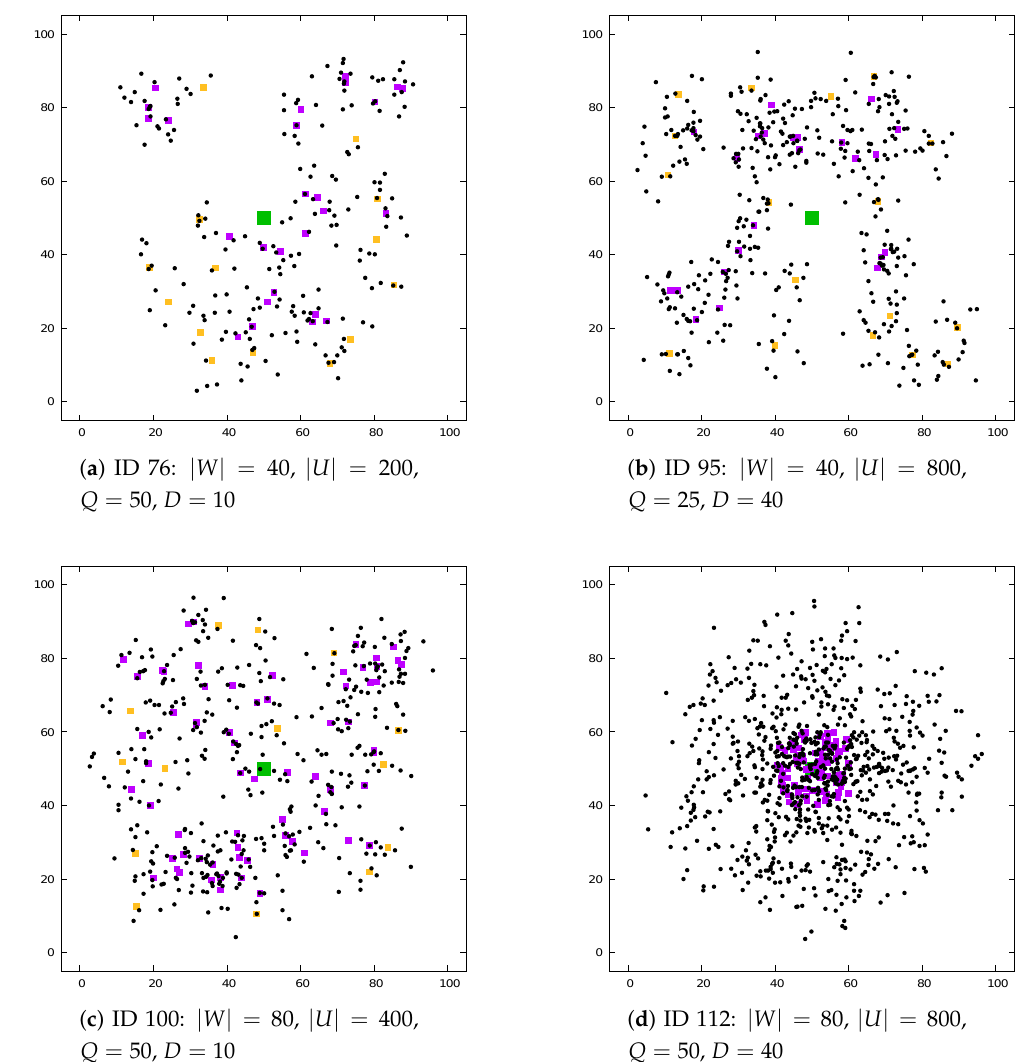
Figure 5. Geographical distribution of six instances. The green square represents the depot. The remaining squares represent bus stops. The yellow squares are the fixed stops. The black balls correspond to